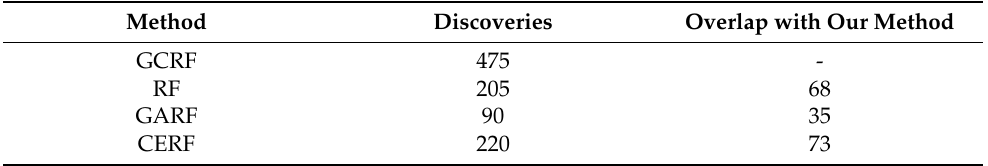
Table 3. The important “subregion-gene pairs” identified by the traditional random forest. GCRF = ge- netic clustering random forest; RF = random forest; GARF = genetic algorithm random forest; CERF = clustering evolutionary random